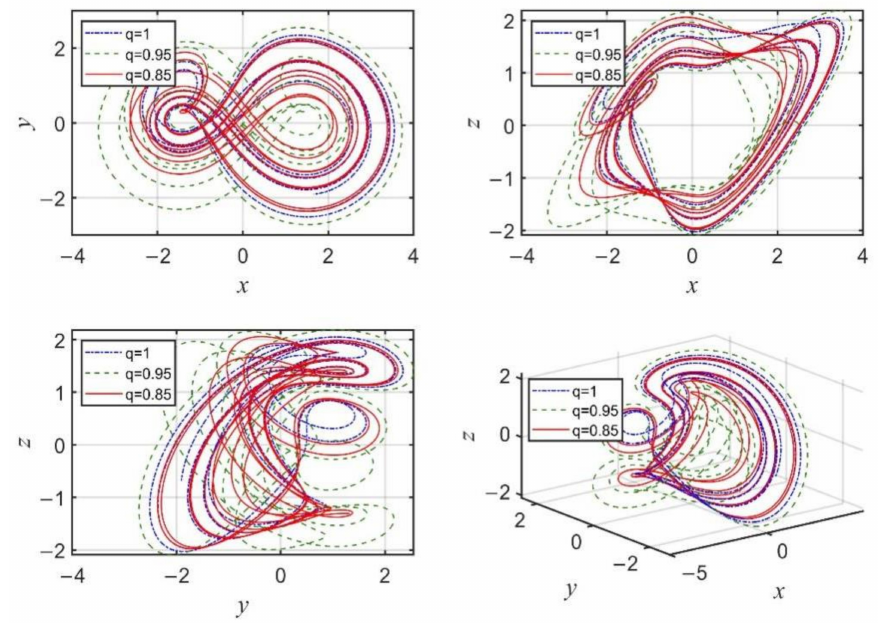
Figure 10. Phase portrait of system (14) with some different orders for a 1 =